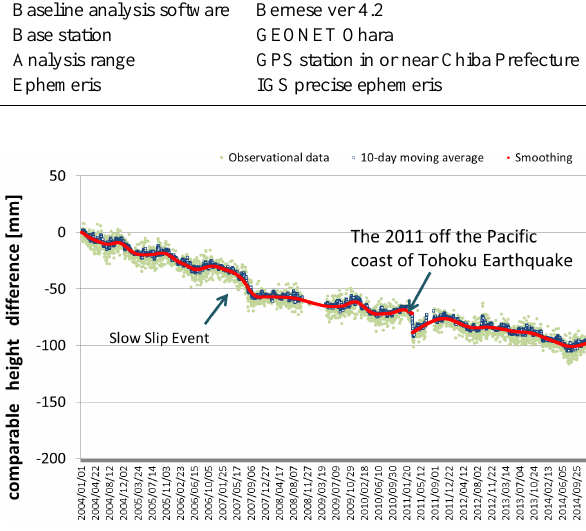
Figure 3. GPS smoothing